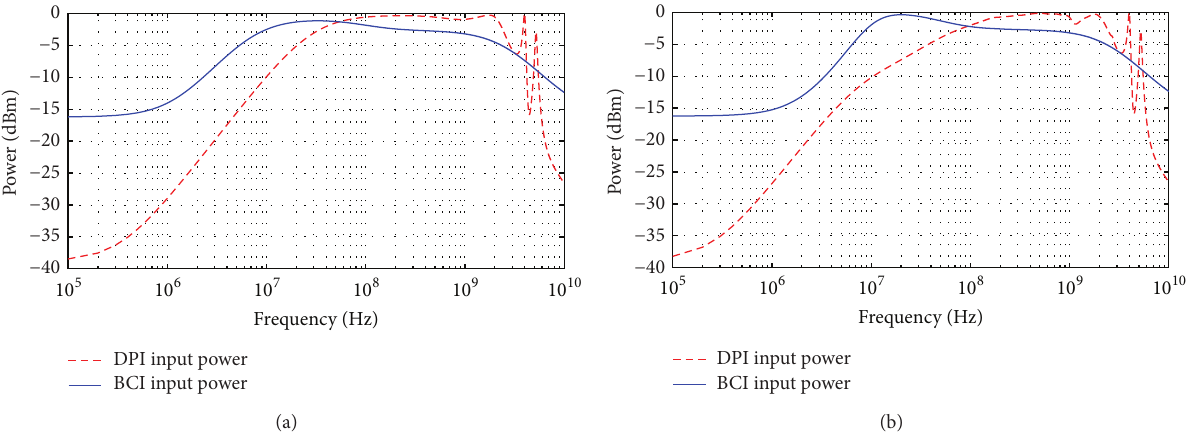
Figure 20: Comparison of DPI and BCI input power ( 𝑃